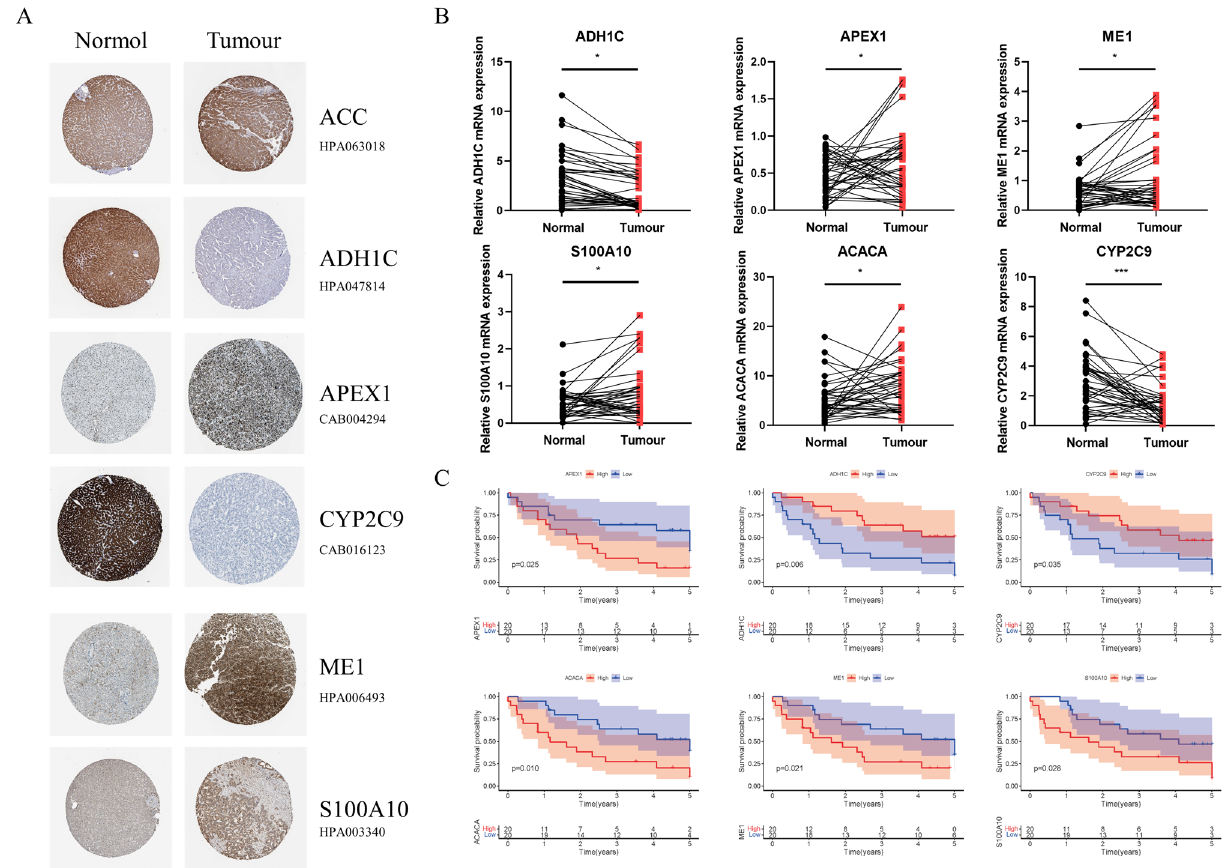
Figure 6. Expression of six lipid metabolism-related genes in hepatocellular carcinoma and their effect on prognosis. ( A ) Expression of risk-related genes in liver cancer tissues and adjacent normal tissues (HPA database). ( B ) 6 lipid metabolism related genes mRNA levels in tumor tissues and adjacent normal tissues (patients treated at People’s Hospital of Zhengzhou University). ( C ) Survival curve of patients with high and low risk scores (patients treated at People’s Hospital of Zhengzhou